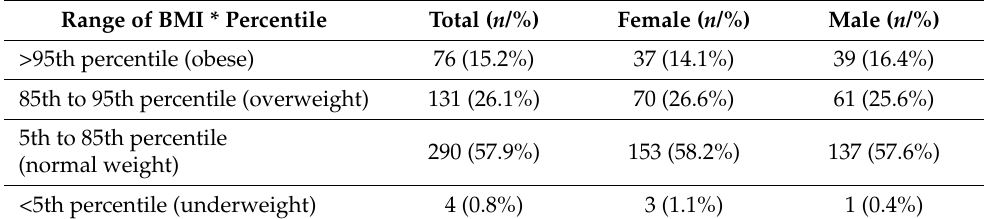
Table 1. Weight status categories by